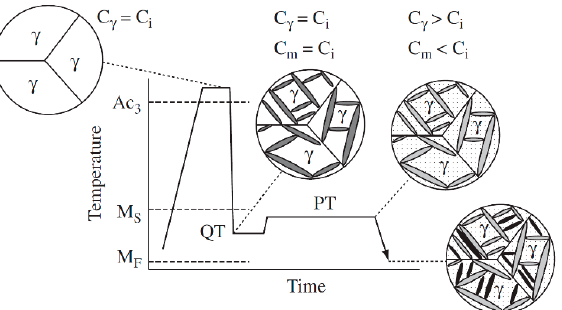
Figure 1. Thermal process to develop QP steels. QT and PT correspond to quenching and partitioning temperatures [5]. Copyright obtained from Elsevier. C i , C γ , and C m are the carbon contents of the initial alloy, austenite, and martensite, respectively. Reproduced with permission of the editor.